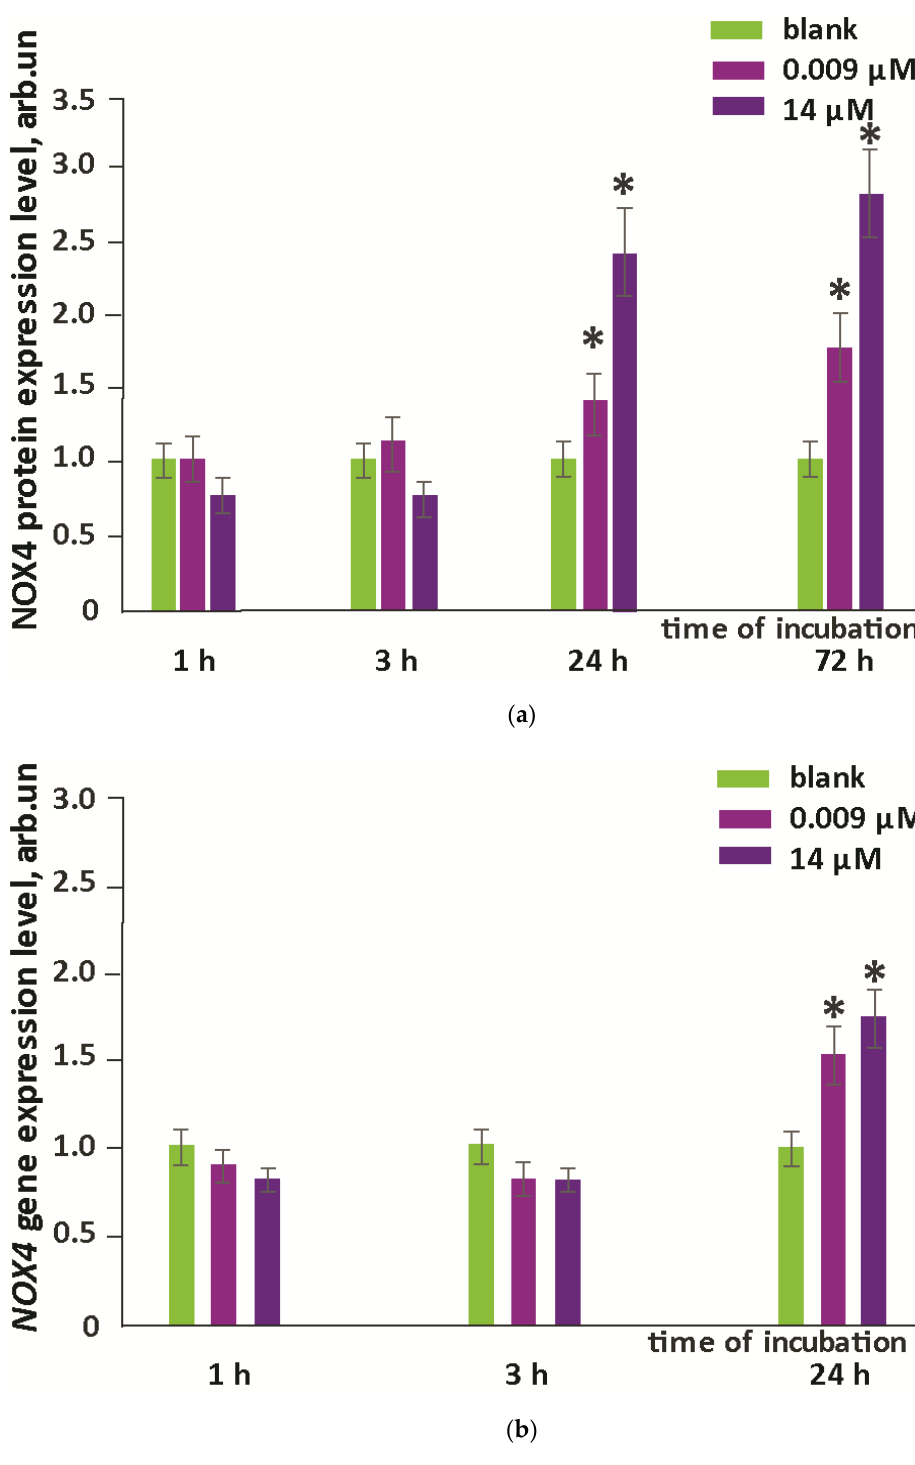
Figure 5. NOX4 protein ( a ) and NOX4 gene expression ( b ) relative to the control values in HELF cells after the incubation with F1 . TBP was used as an internal standard gene. Significant differences with the control by the Mann − Whitney test ( p < 0.01) are denoted by “*”.